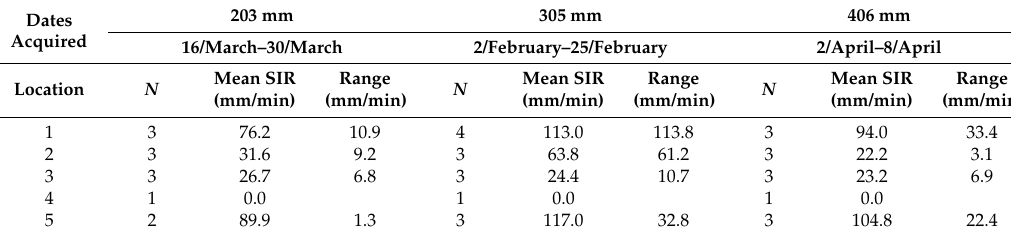
Table 1. SIR data collected on the porous asphalt surface in the spring of 2016 using the ASTM C1701 standard test with varying ring sizes. Sample size N (of the data leading to the mean SIR and range given) is provided for each location tested on the surface. The dates encompassing the period of collection are shown as day/month. Means are given instead of the median as the latter cannot be computed with less than 3 points.